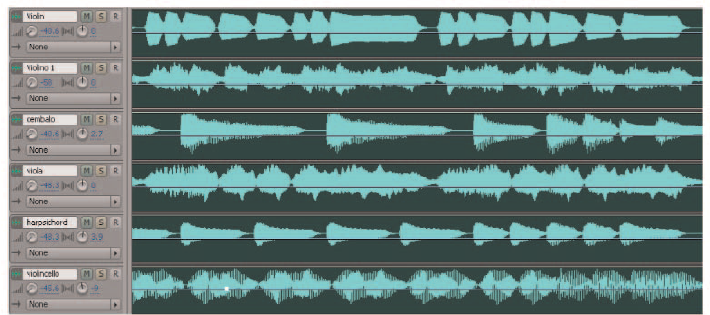
Figure 7. Different instrument tracks for TM implementation in the Model Human Cochlea, retrieved from in